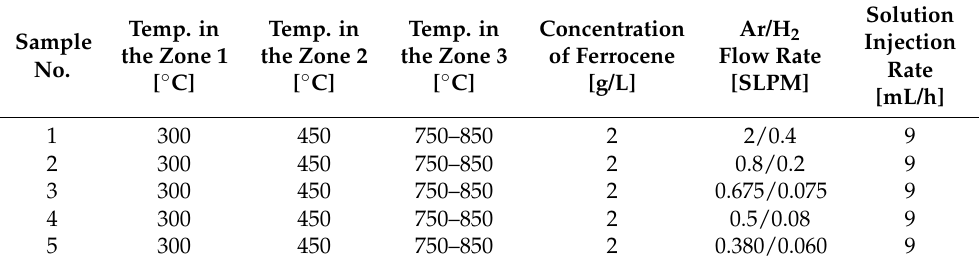
Table 1. Conditions of the experiments.